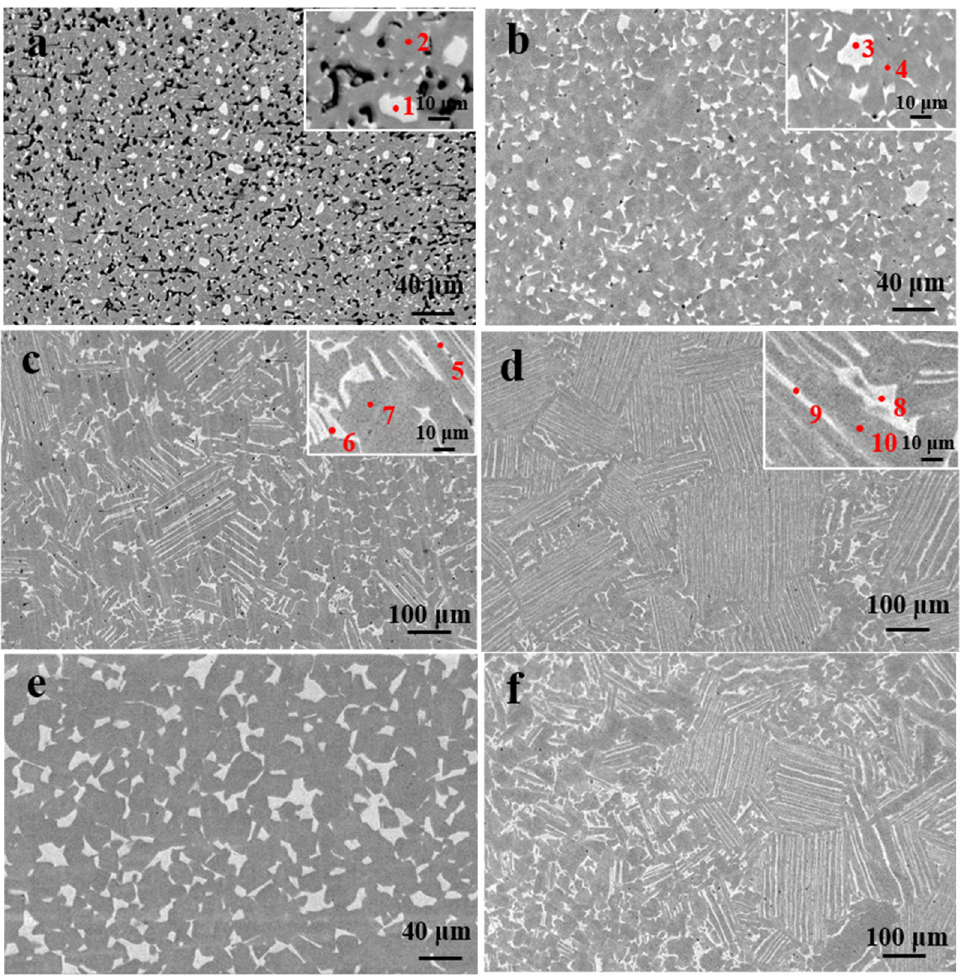
Figure 6. SEM images of as-sintered samples: ( a ) 1300 °C, ( b ) 1350 °C, ( c ) 1400 °C, ( d ) 1450 °C ( e ) 1350 °C/HIP, and ( f ) 1400 °C/HIP. The marked red numbers are corresponding to the measured EDS positions shown in Table 3. Table 3. Chemical composition of different regions marked in Figure 6 obtained by EDS analysis.